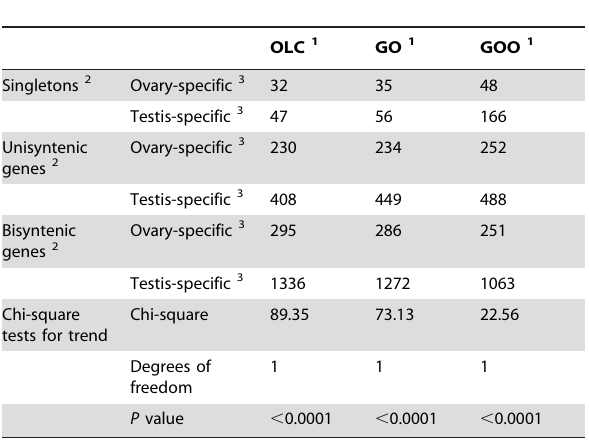
Table 1. Distribution of ovary- and testis-specific genes within three classes of OL genes according to the changes in their flanking genes in the Drosophila